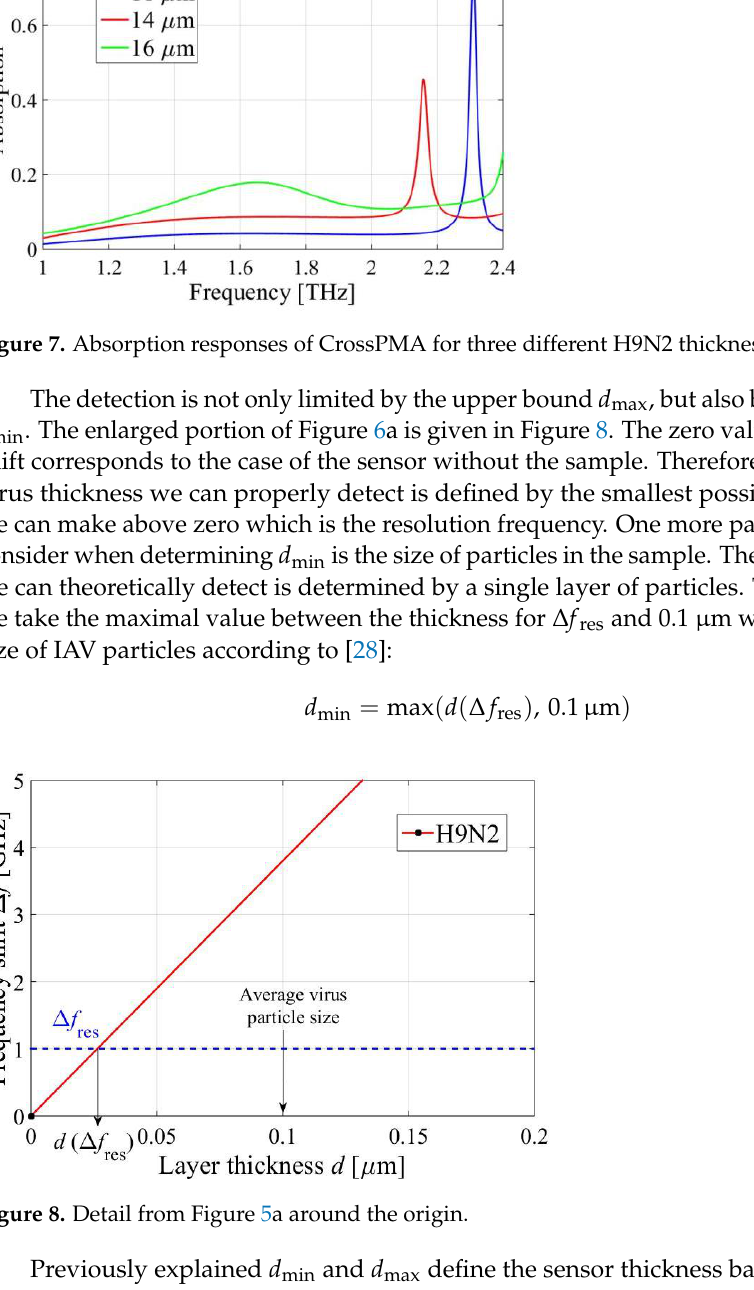
Figure 8. Detail from Figure 5a around the origin. Previously explained d and max d min